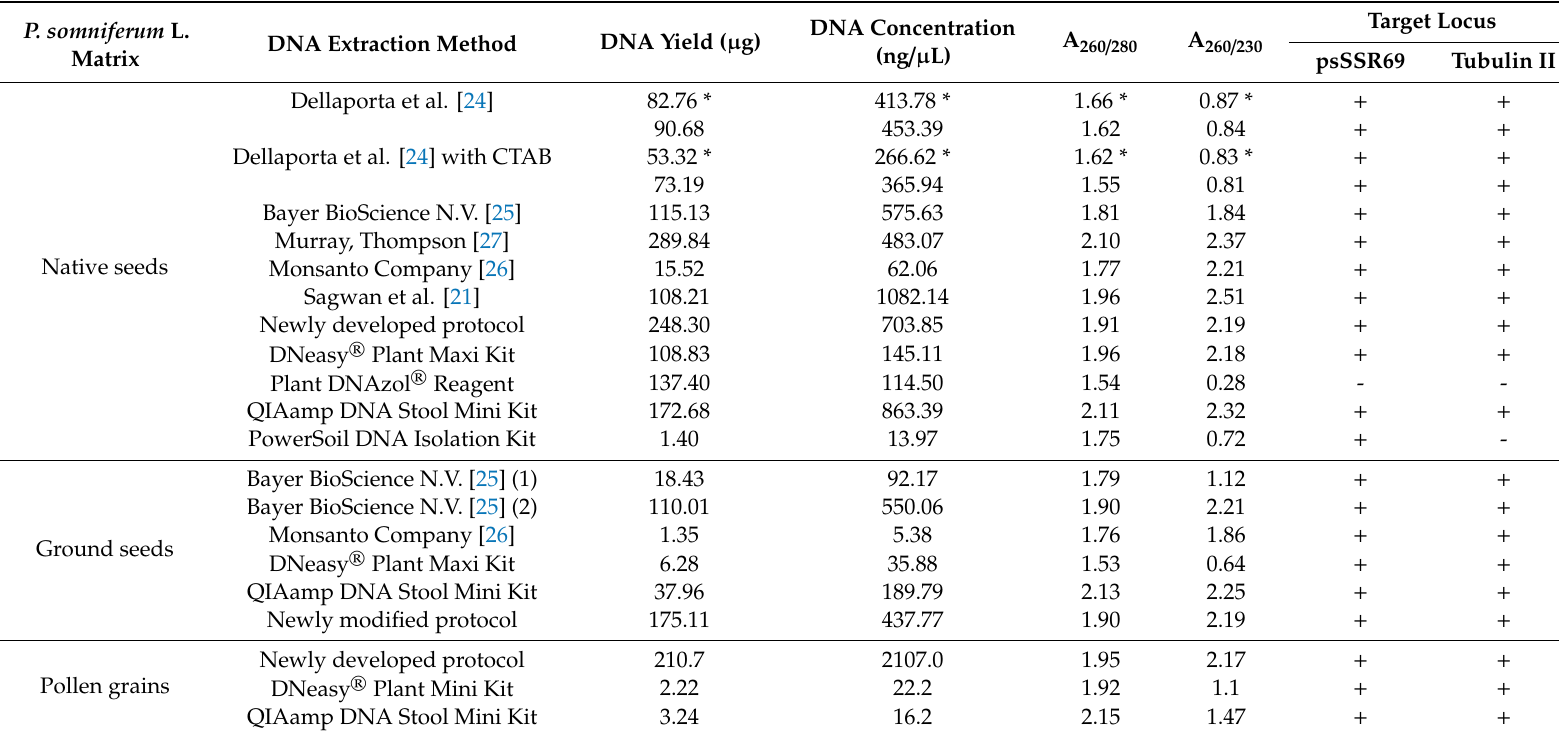
Table 2. Parameters of DNA extracted from opium poppy native seeds, ground seeds, and pollen grains by di ff erent extraction procedures and commercial kits. P. somniferum